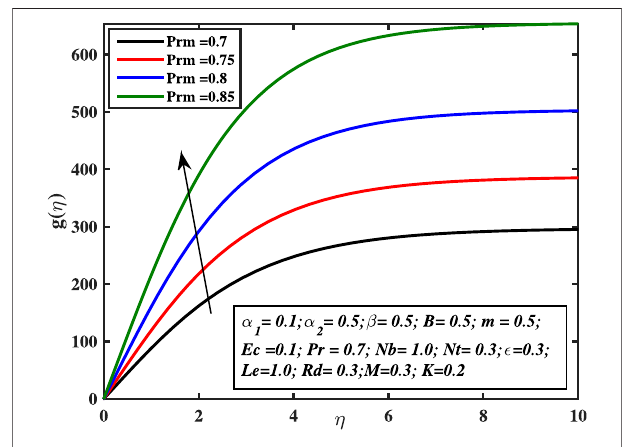
FIGURE 19 | In fl uence of Prm on induced magnetic velocity.